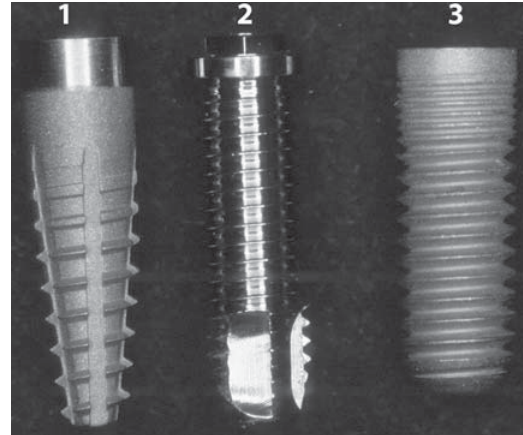
Figure 2- Implant systems used in the study: Intern Octagon (1); External Hexagon (2) and Intern Hexagon (3)